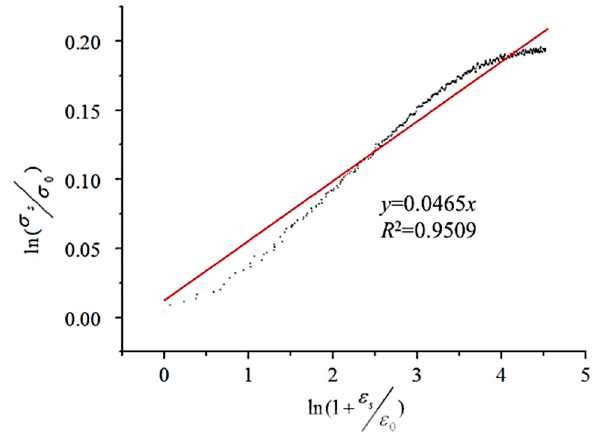
Figure 7. The relationship between ln( σ s / σ 0 ) and ln(1 + ε s / ε 0 ).